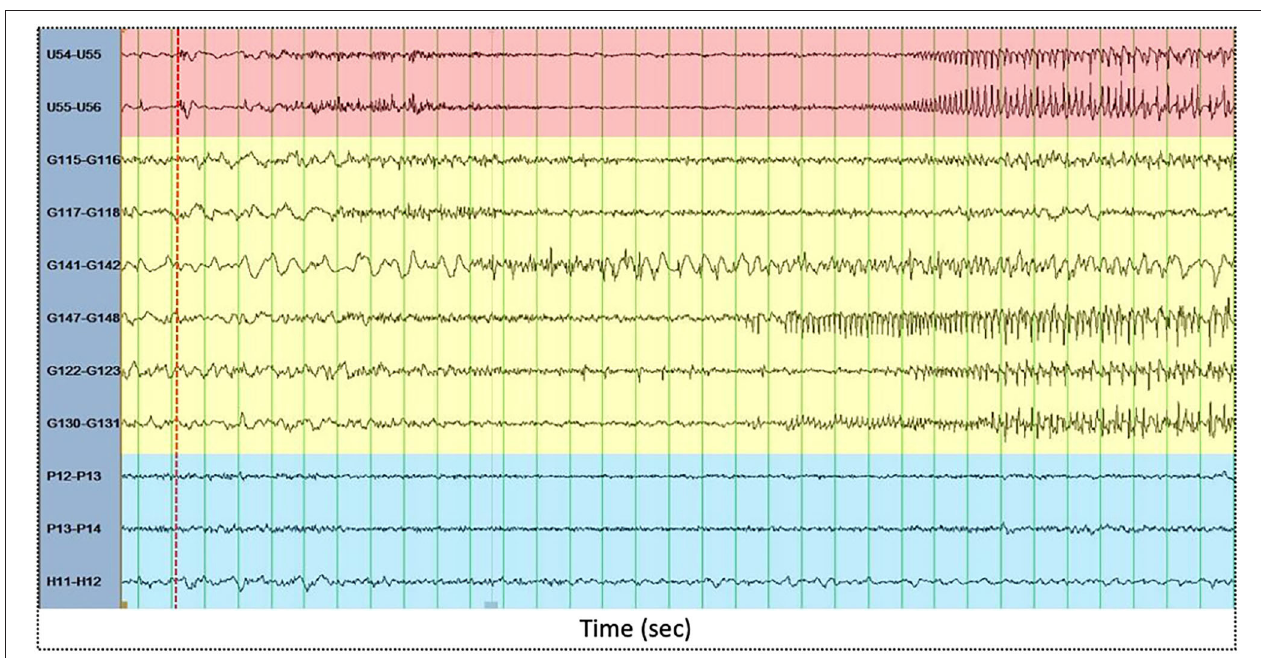
FIGURE 1 | Illustrative examples of intracranial EEG ictal signals recorded by electrodes within the focus area (red), propagation area (yellow) and silent area (blue). The x-axis displays time (in seconds). Green vertical lines are spaced one second each. The red dashed vertical line displays electrical seizure onset.